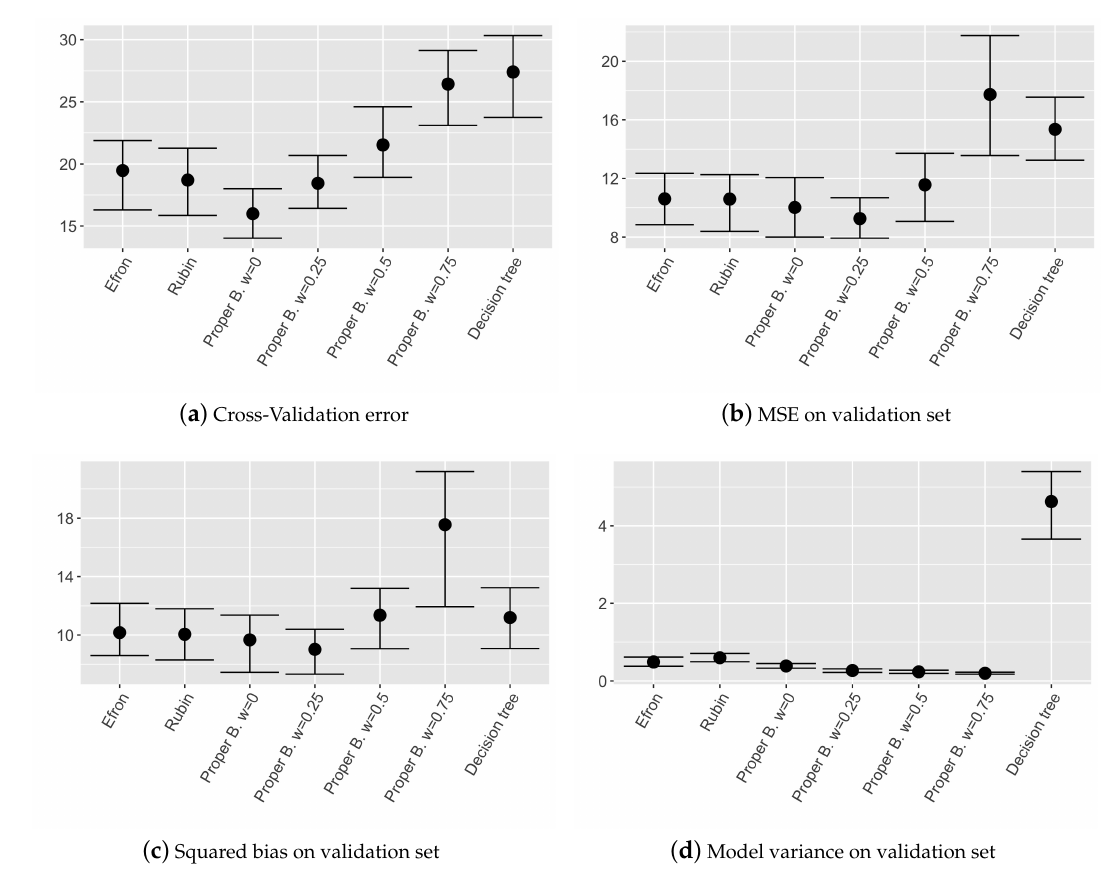
Figure 6. Nonparametric confidence intervals on obtained results in real